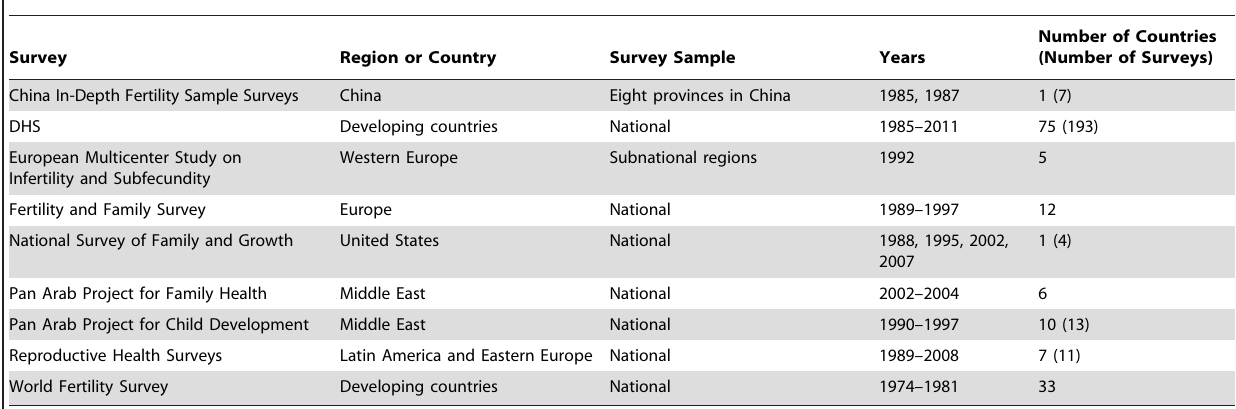
Table 1. Surveys included in the